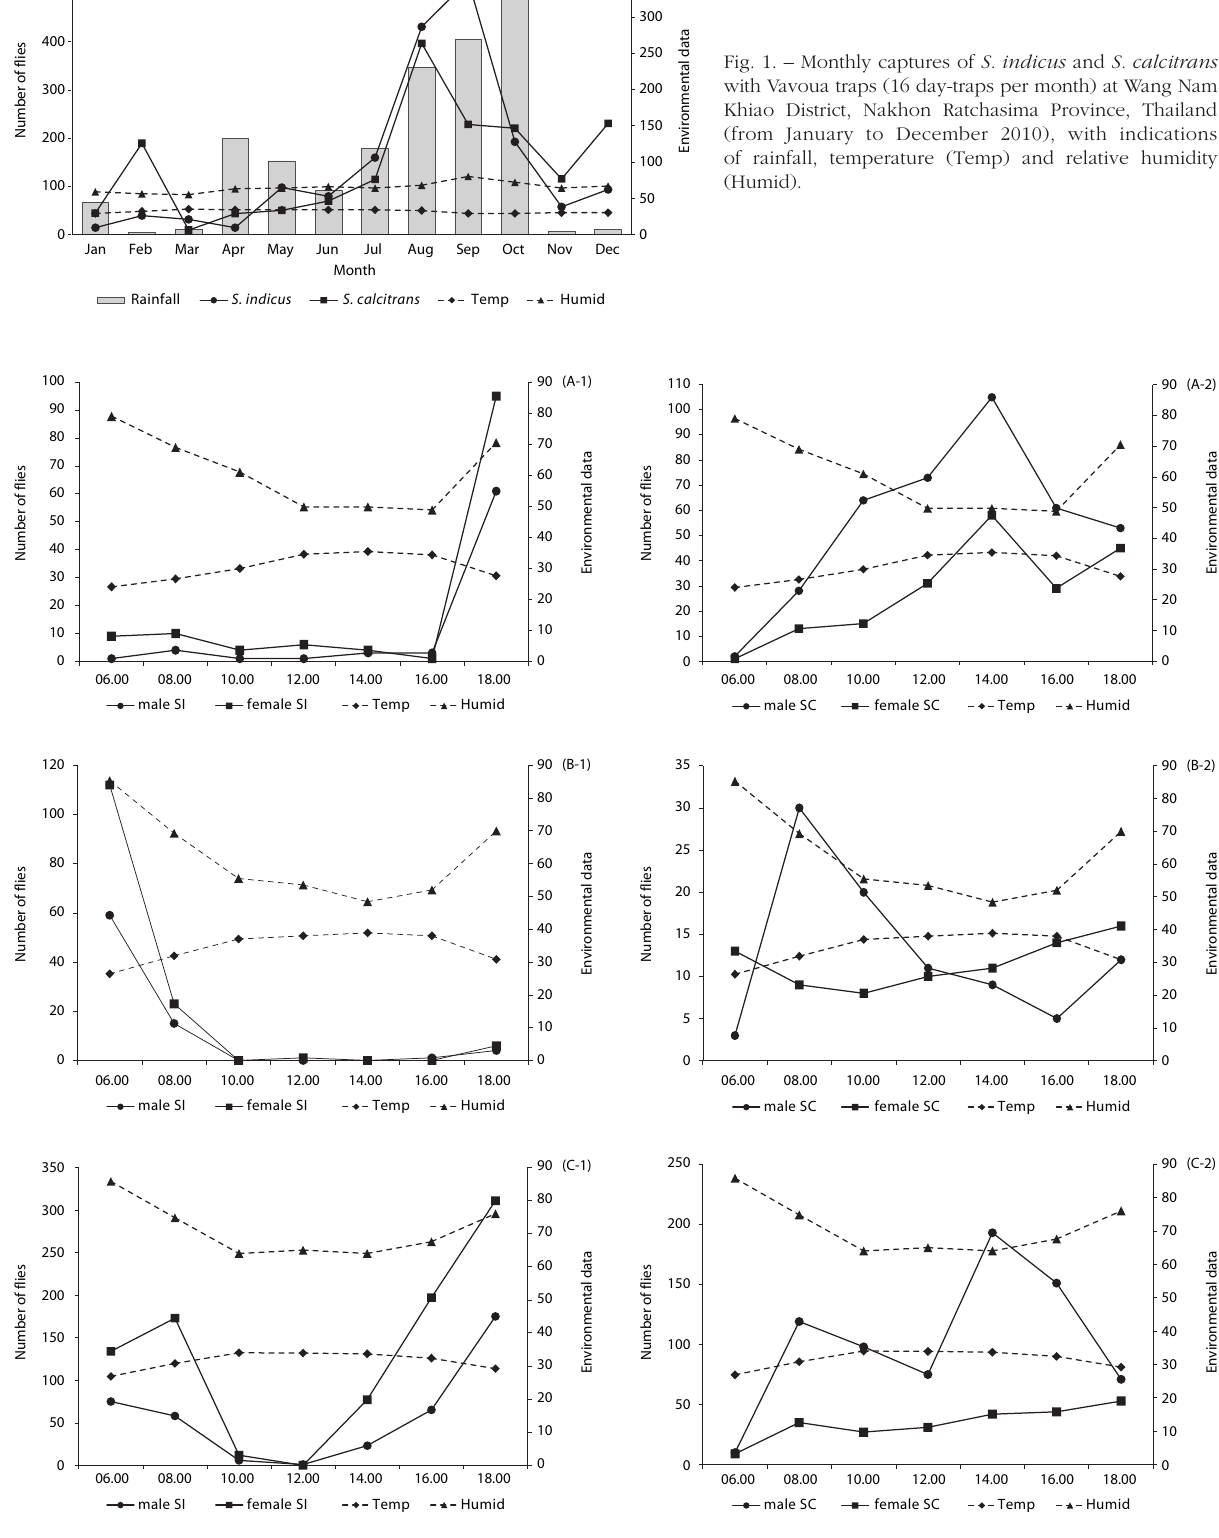
Fig. 1. – Monthly captures of S. indicus and S. calcitrans with Vavoua traps (16 day-traps per month) at Wang Nam Khiao District, Nakhon Ratchasima Province, Thailand (from January to December 2010), with indications of rainfall, temperature (Temp) and relative humidity